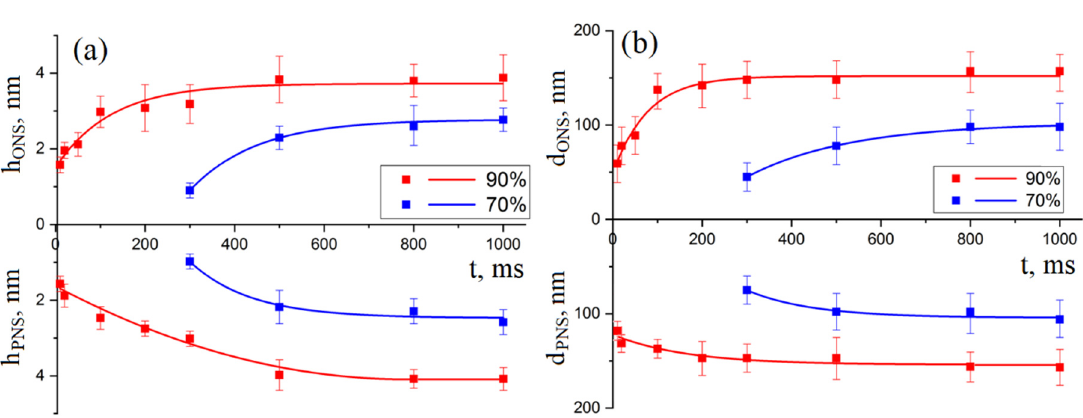
Figure 4. Dependences of the geometric parameters of nanostructures on the duration of the voltage. The amplitude of the applied voltage is 10 V, the feedback circuit current is 2 nA, the air humidity is 1—90 ± 1% and 2—70 ± 1%: ( a )—the height of the ONS and the depth of the PNS; ( b )—the diameter of the ONS and PNS.